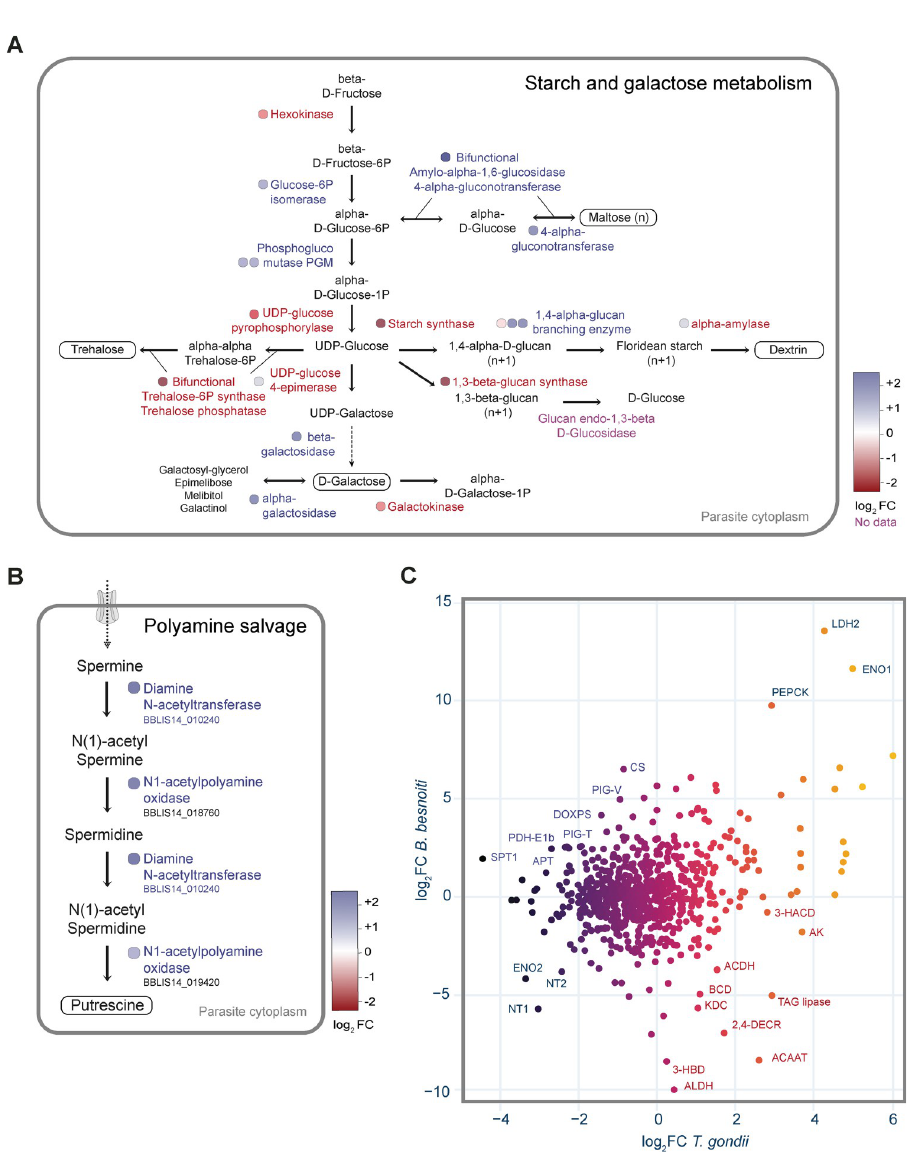
Fig 9. Upregulated pathways and correlation of gene expression levels the T . gondii transcriptomic profile in bradyzoites. (A) The starch and galactose metabolic pathway with their gene expression in bradyzoites highlighted from red (downregulated) to blue (upregulated). Bubbles in shades of red or blue mark the level of regulation. Note that hexokinase belongs to the glycolysis pathway but is highlighted because its activity initiates the starch and galactose pathway. (B) Schematic representation of the polyamine salvage pathway and their high expression level in the latent stage of B . besnoiti . Bubbles in shades of blue highlight the high level of upregulation in B . besnoiti bradyzoites. (C) Correlation of the ratio of gene expression between bradyzoites and tachyzoites in B . besnoiti compared to T . gondii of all known metabolic genes in these coccidan species. Genes upregulated only in B . besnoiti but not in T . gondii are highlighted in blue and highlighted in red are genes upregulated only in T . gondii bradyzoites. 2,4-DECR: 2,4-dienoyl CoA reductase 2; 3-HACD: 3-hydroxyacyl-CoA dehydrogenase; 3-HBD: 3-hydroxyisobutyrate dehydrogenase; ACAAT: acetyl-CoA C-acyltransferase, ACDH: Acyl-CoA dehydrogenase domain-containing protein; AK: adenylate kinase; ALDH: alanine dehydrogenase; APT: aminopeptidase n; BCD: Butyryl-CoA dehydrogenase; CS: citrate (si)-synthase; DOXPS: 1-deoxy-D-xylulose 5-phosphate synthase; ENO1: enolase 1; ENO2: enolase 2; KDC: lysine decarboxylase family protein; LDH2: lactate dehydrogenase 2; NT1: nitrite transporter 1; NT2: nitrite transporter 2, PDH-E1b: pyruvate dehydrogenase E1 beta subunit; PEPCK: Phosphoenoylpyruvat (PEP) carboxykinase; PIG-T: GPI-anchor transamidase; PIG-V: mannosyltransferase; SPT1: serine C-palmitoyltransferase 1; TAG lipase: triacylglycerol lipase.